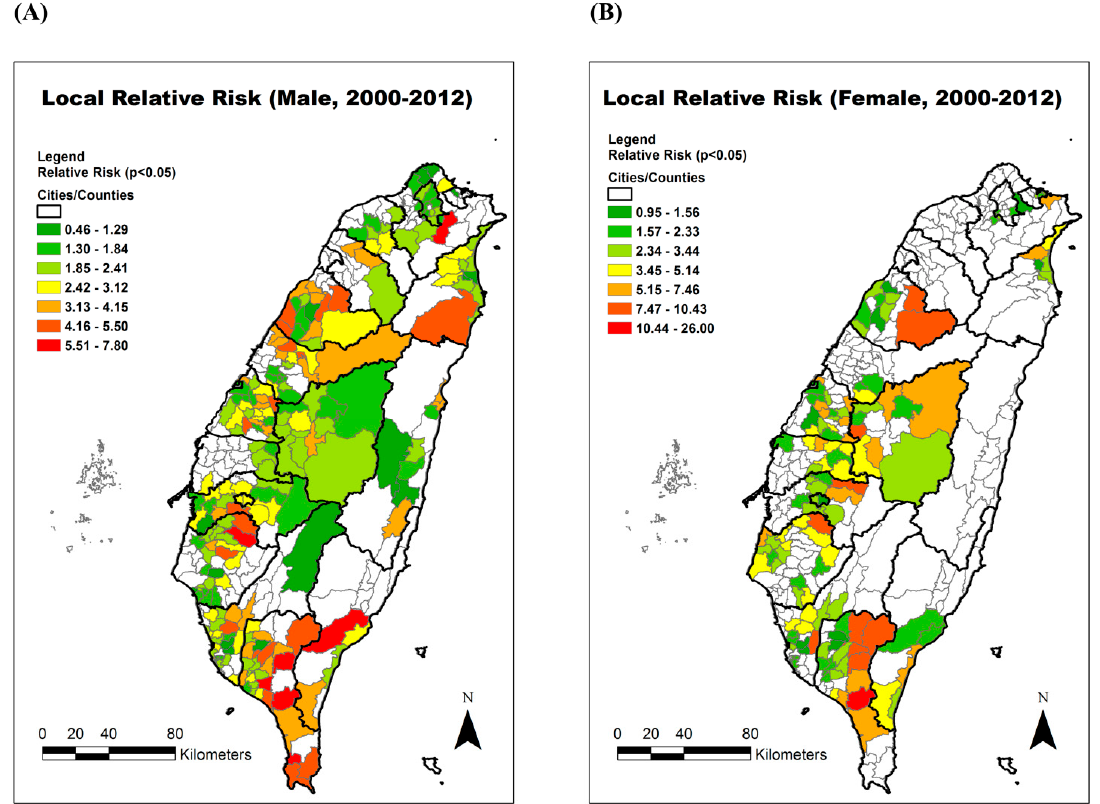
Figure 2. The estimated local relative risk of chronic obstructive pulmonary disease (COPD) in Taiwan from 2000–2012. ( A ) Male; ( B ) Female.